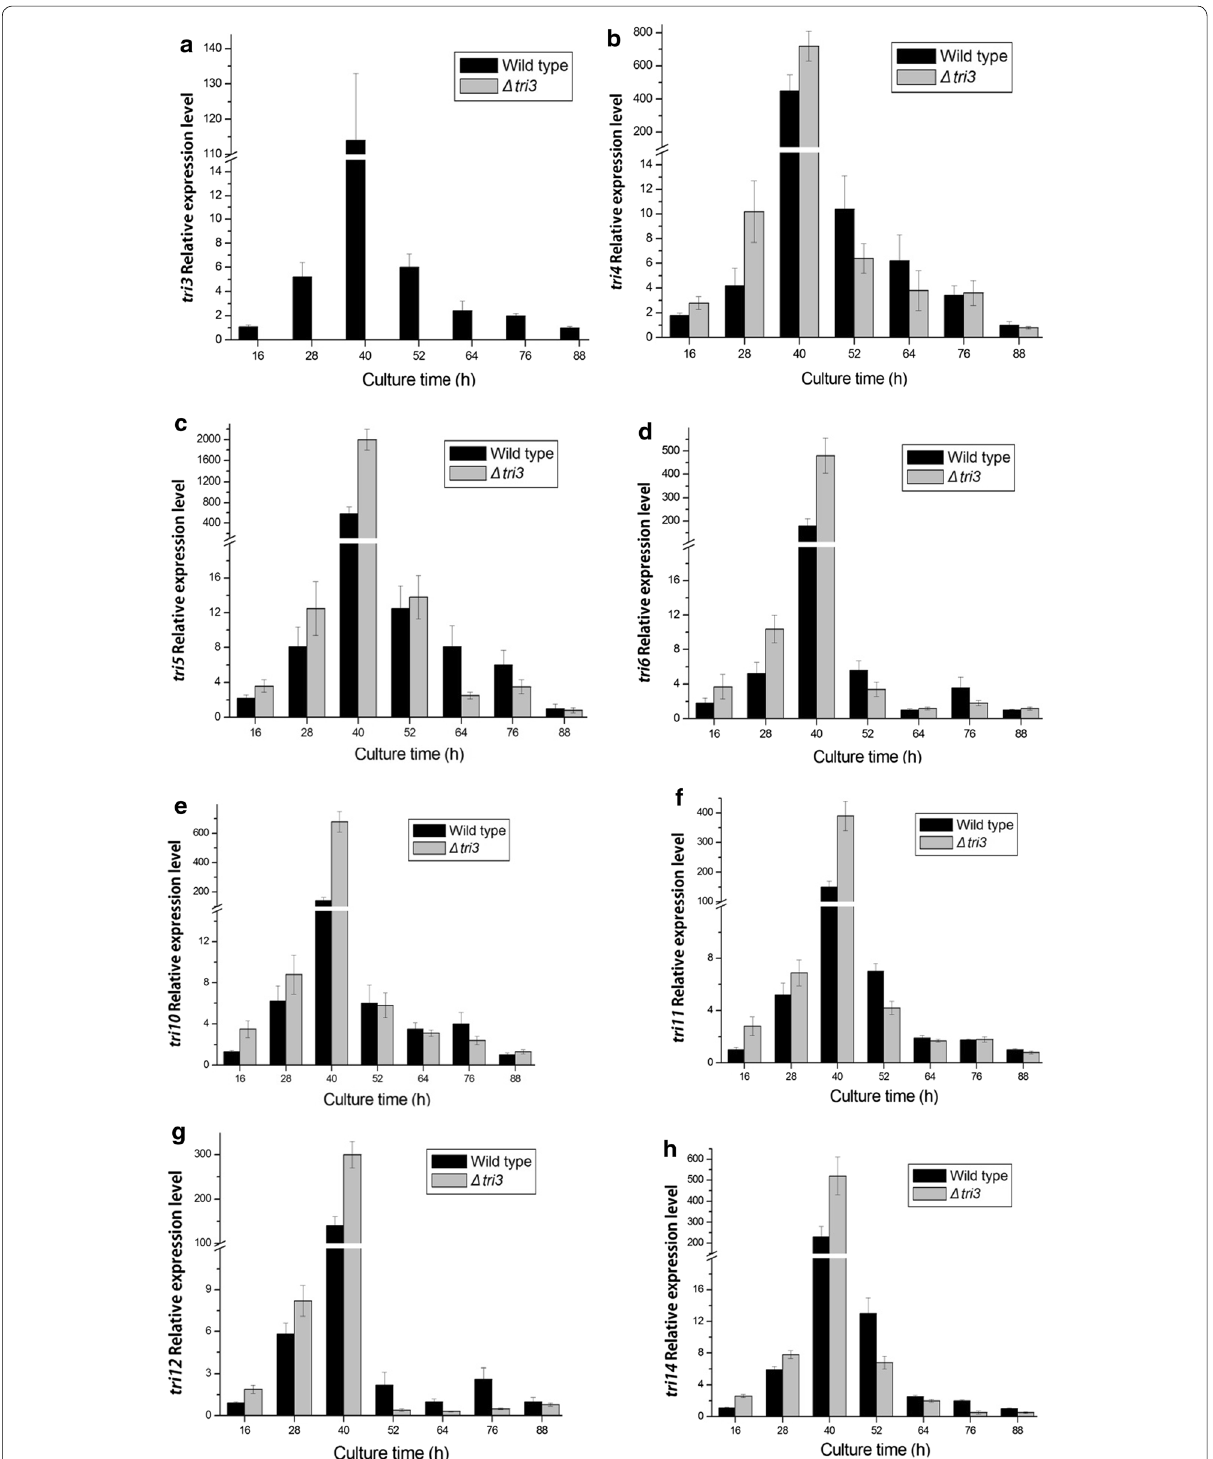
Fig. 3 Expression of tri genes in Δ tri3 mutant and wild strain. The quantification of tri3 gene expression in the different culture times was analyzed by 2 − ΔΔCt method. The wild strain cultured for 88 h was used as control and β - tubulin as reference gene. a tri3 , b tri4 , c tri5 , d tri6 , e tri10 , f - tri11 , g tri12 , and h